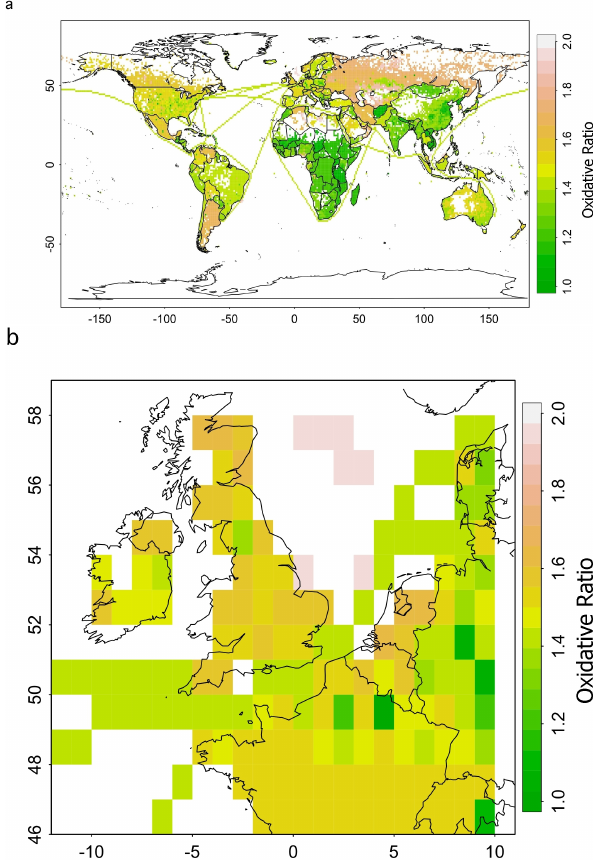
Fig. 2. The global distribution of the oxidative ratios from fossil fuel combustion (a) and the regional distribution at our sampling locations in more detail (b) (Steinbach et al., 2010). These are the emissions based fossil fuel ORs per grid cell and are used as an input in the used regional model study. White grid cells indicate that no data is available in the EDGAR database. For Lutjewad the average of the two grid cells just below the actual position has therefore been used in this